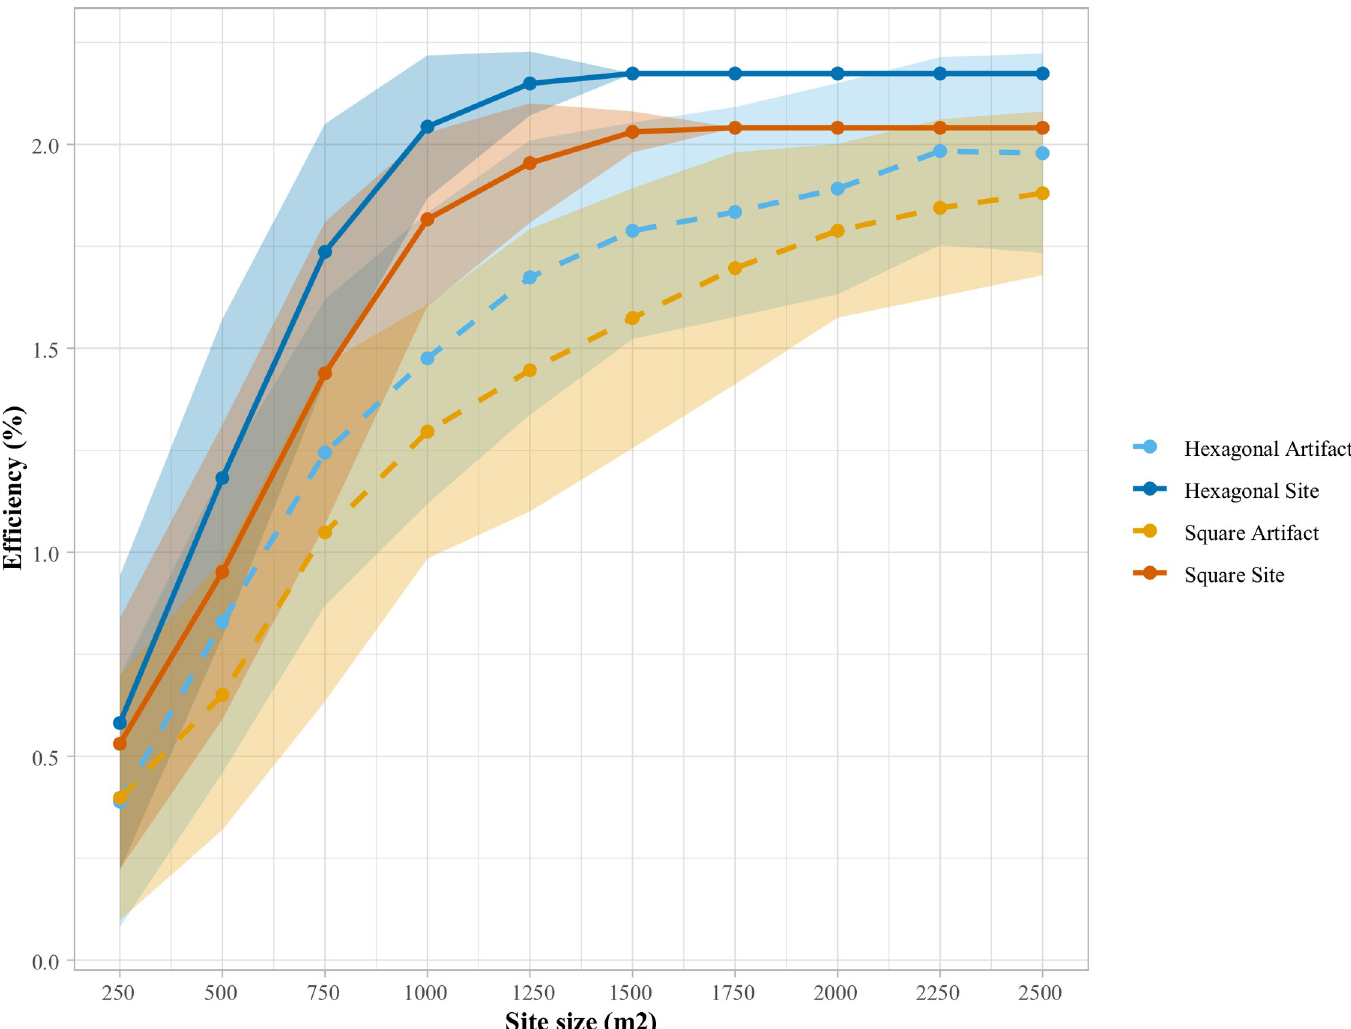
Fig 5. Comparison of square and hexagonal grid efficiency, parameters as follows: 0.2 x 0.2 km survey region, eight randomly located sites, 5 artifacts/m 2 , uniform distribution, up to 50% overlap between sites, 100 simulations. For both square and hexagonal grids, an inter-unit spacing of 33 m was specified, with site areas ranging from 250–2500 m 2